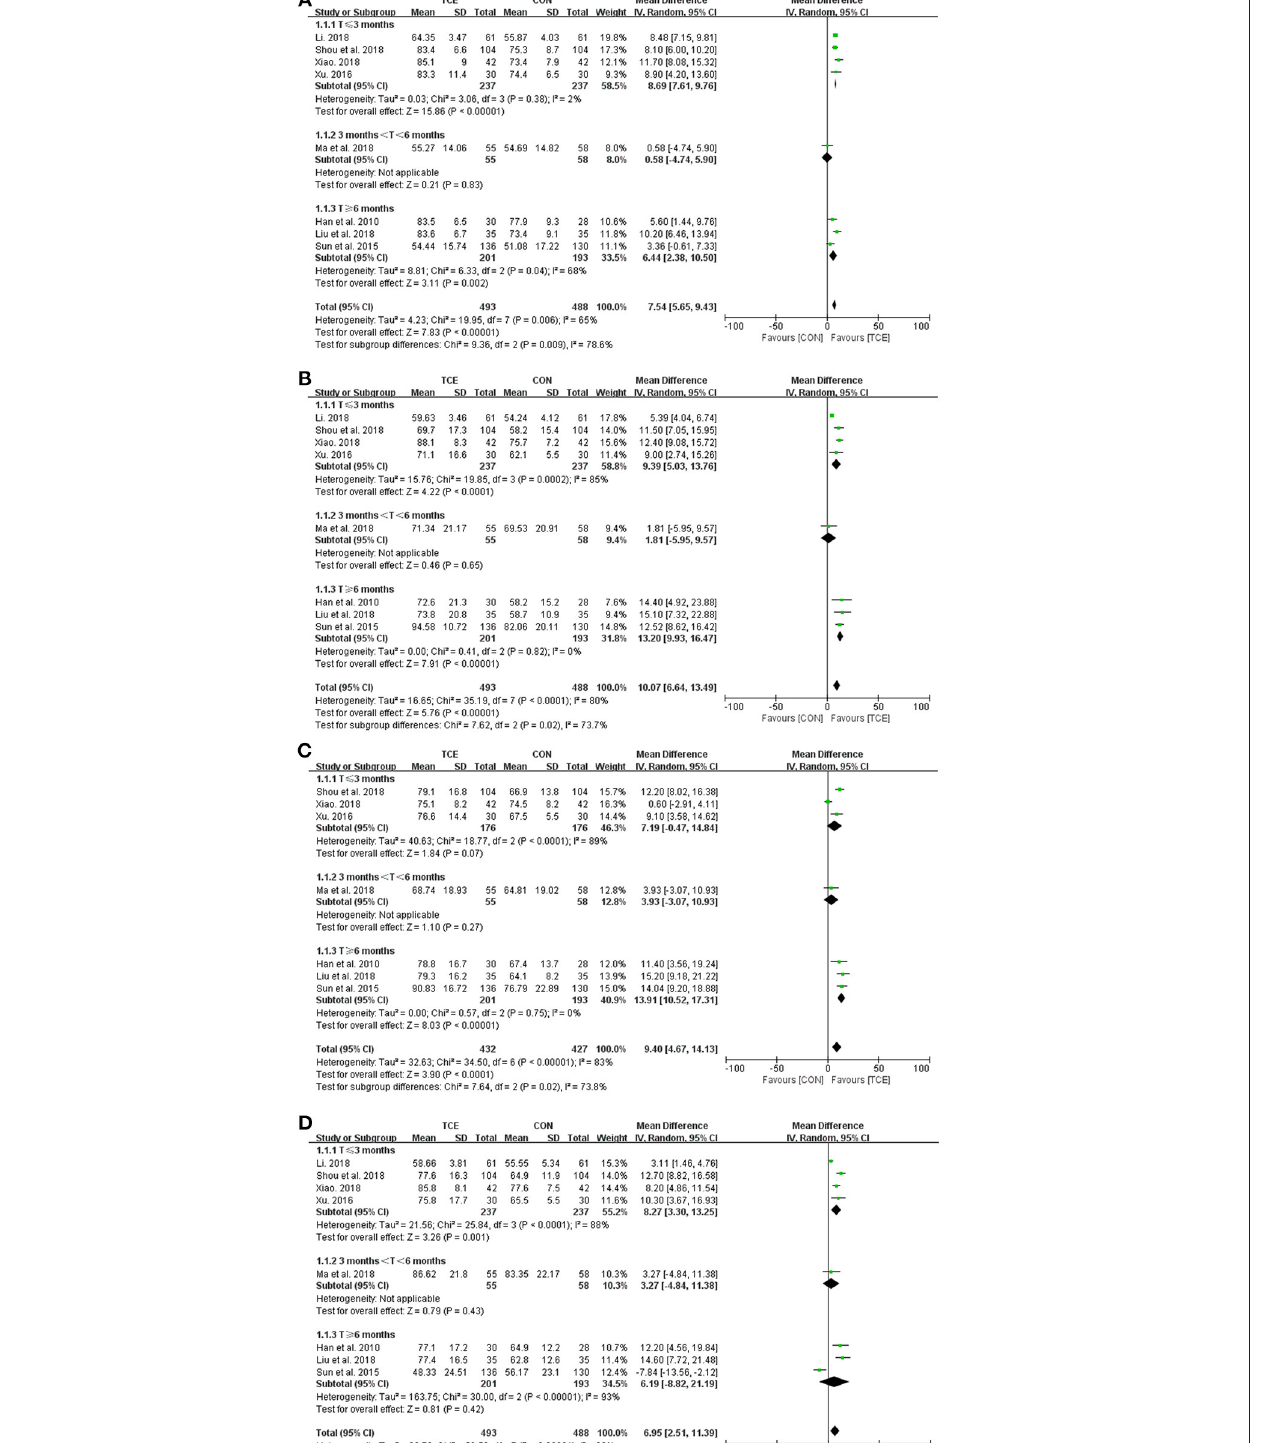
Frontiers in Cardiovascular Medicine |